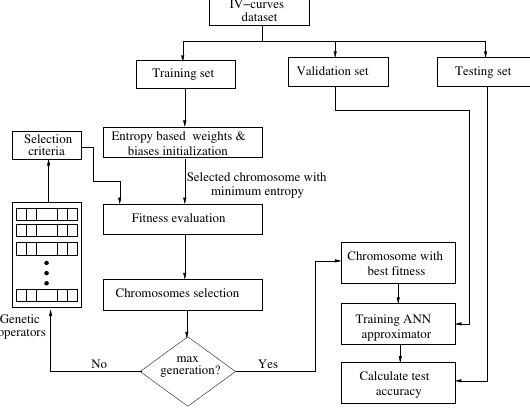
Figure 4. Flow chart depicting the proposed